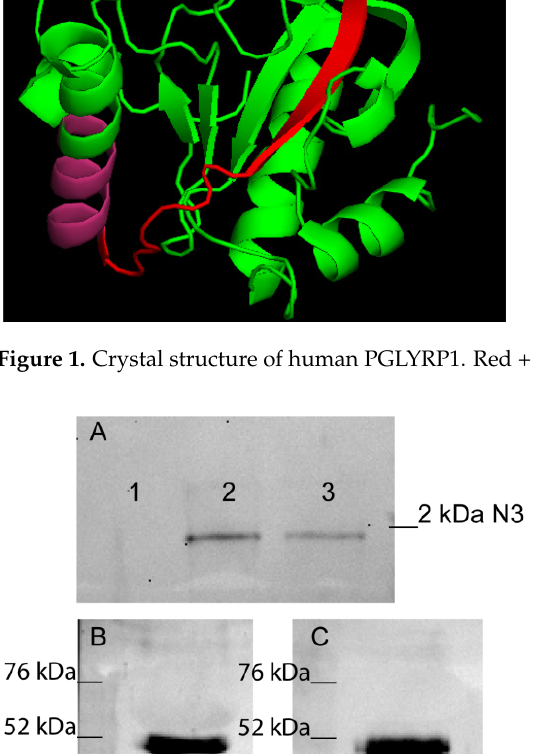
Figure 1. Crystal structure of human PGLYRP1. Red + pink—N3 peptide, pink—p.7 as a part of N3.